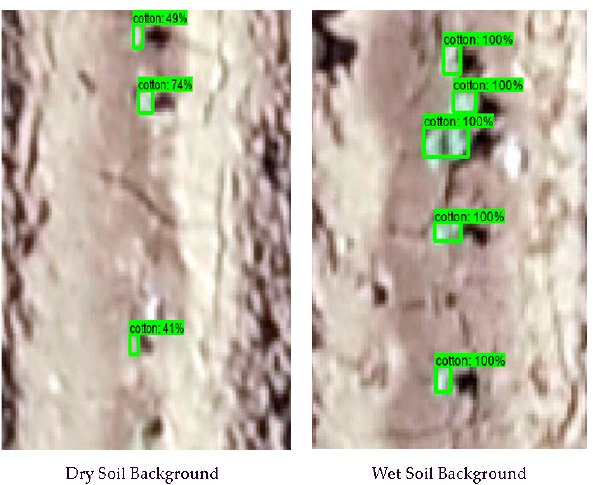
Figure 6. Examples of cotton plant detection and counting results using unmanned aerial system images at dry and wet soil conditions. Percentage labels around bounding boxes represent F1-scores for detected cotton